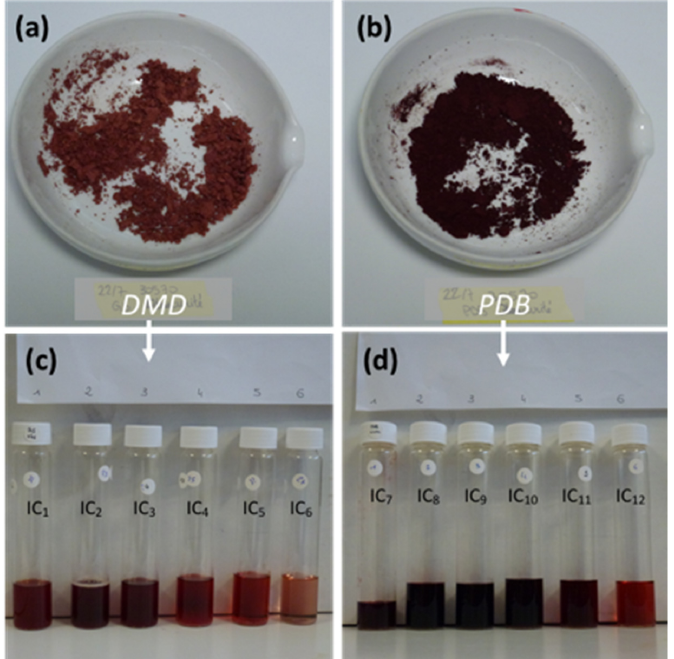
Figure 2. Red-colored dried residues obtained from submerged culture of the marine-derived Talaromyces sp. 30570 strain ( a ) in DMD, or ( b ) in PDB medium; ( c , d ) intracellular (IC) liquid extracts obtained using the pressurized liquid extraction method on mycelial cells of Talaromyces sp. 30570. The sequence of solvents was set to display a decreasing polarity profile (from IC 1 to IC 6 ; or from IC 7 to IC 12 ): purified water was used as the first extraction solvent, followed by 50% aqueous methanol, then 50% aqueous ethanol, >99.9% methanol, and MeOH:EtOH (1/1, v/v ), and >99.9% ethanol as the last extraction